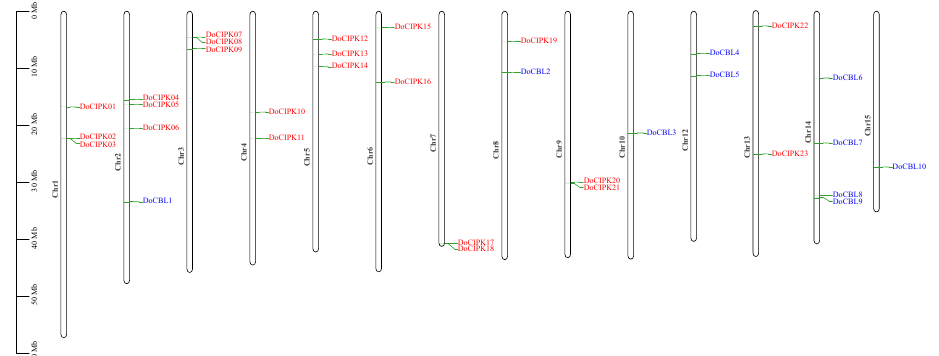
Figure 2. The distribution of CBL – CIPK genes on oil persimmon chromosomes. DoCBL and DoCIPK genes are represented in blue and red,